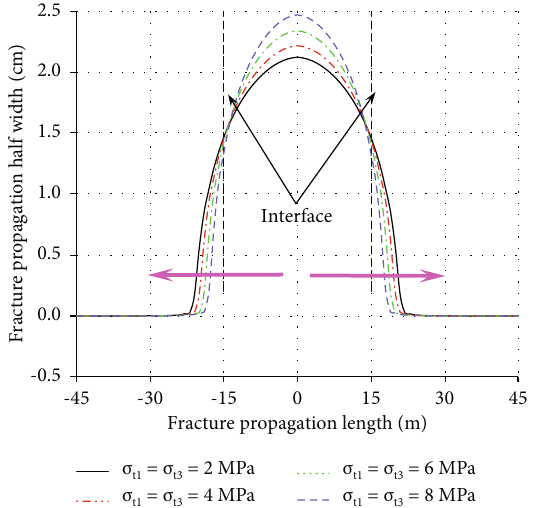
Figure 13: E ff ect of tensile strength contrast on the fracture propagation